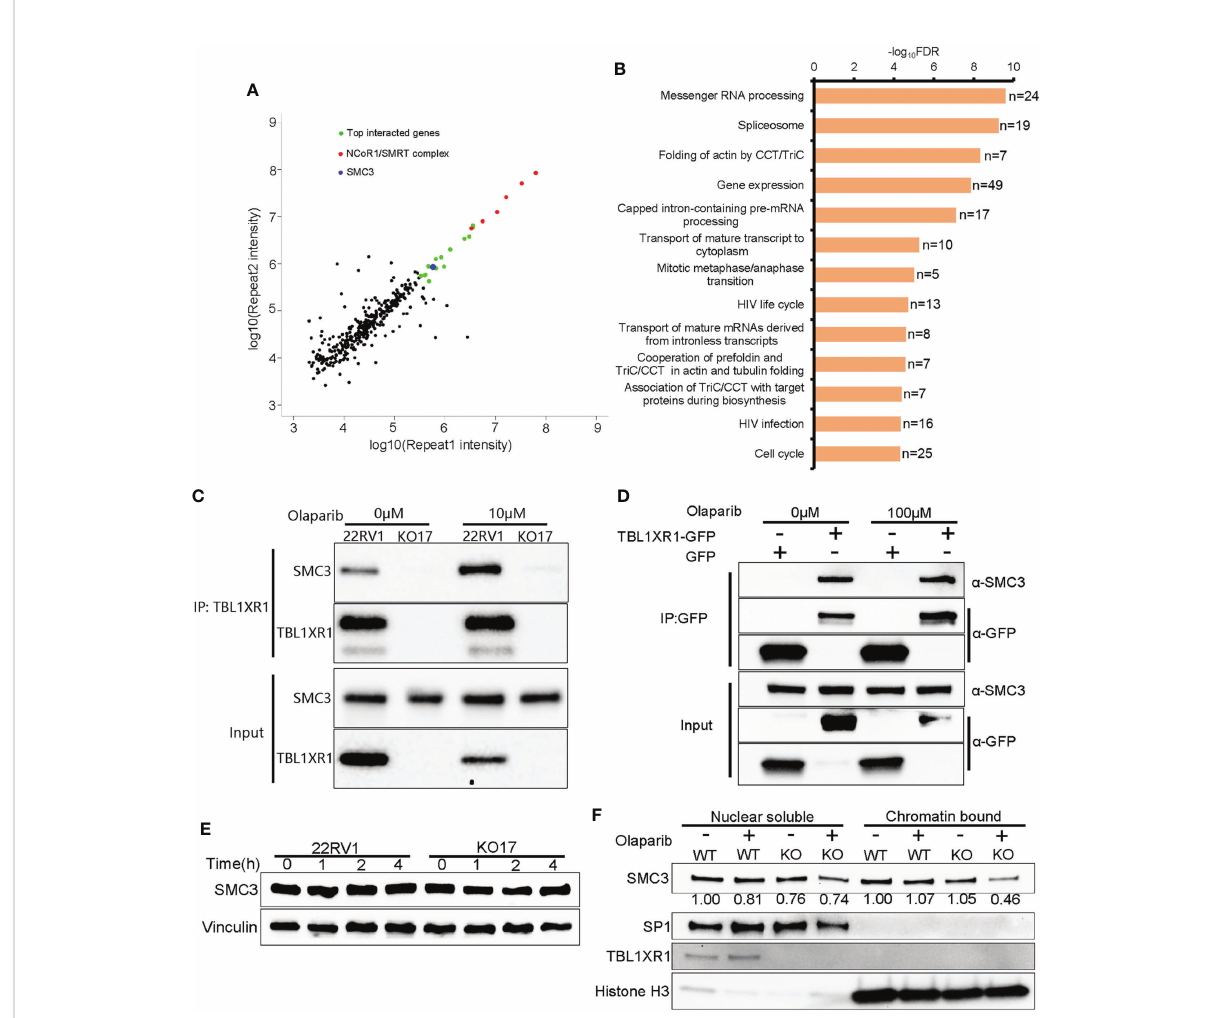
FIGURE 5 The interaction between TBL1XR1 and SMC3. (A) Distribution of IP-MS intensity of the two replicates. (B) Pathway analysis of IP-MS signals. (C, D) Co-IP validation of interaction between TBL1XR1 and SMC3 in 22RV1 (C) and 293T (D) cells. (E) SMC3 protein levels in 22RV1 and TBL1XR1-de fi cient cells after 0h, 1h, 2h and 4h treatment of 10 m M olaparib. (F) Nuclear soluble and chromatin-bound SMC3 protein levels in 22RV1 and TBL1XR1-de fi cient cells under vehicle or olaparib treatment for 4h. The values of SMC3 protein levels are normalized to SP1 (nuclear soluble) or histone H3 (chromatin-bound) and compared to WT without